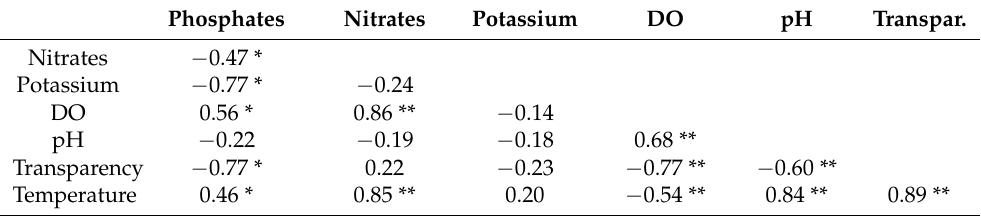
Table 4. Correlation coefficients of water properties of seawater ponds at Garho Fish Farm.